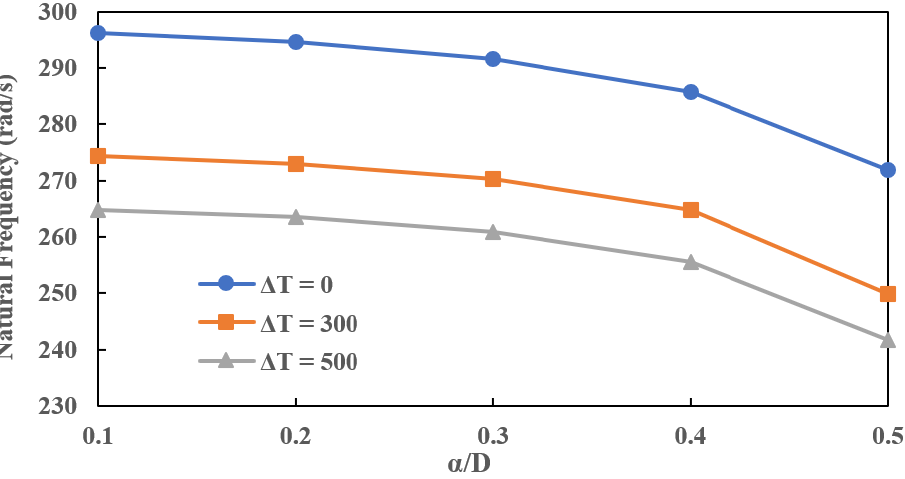
Figure 7. Variation in natural frequencies for different crack depths at different thermal gradients.